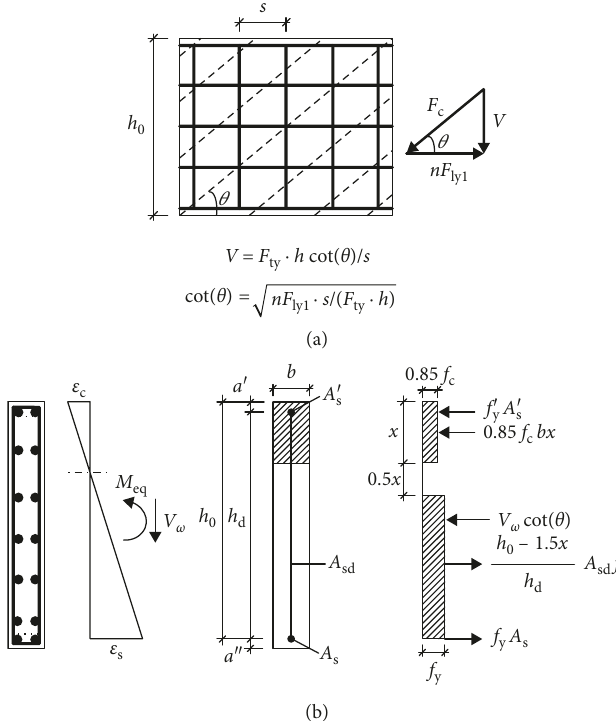
F IGURE 4: Ultimate equilibriums under the combined actions of warping moment and warping torque: (a) the truss model bearing the equivalent shear force and (b) ultimate equilibrium in the normal